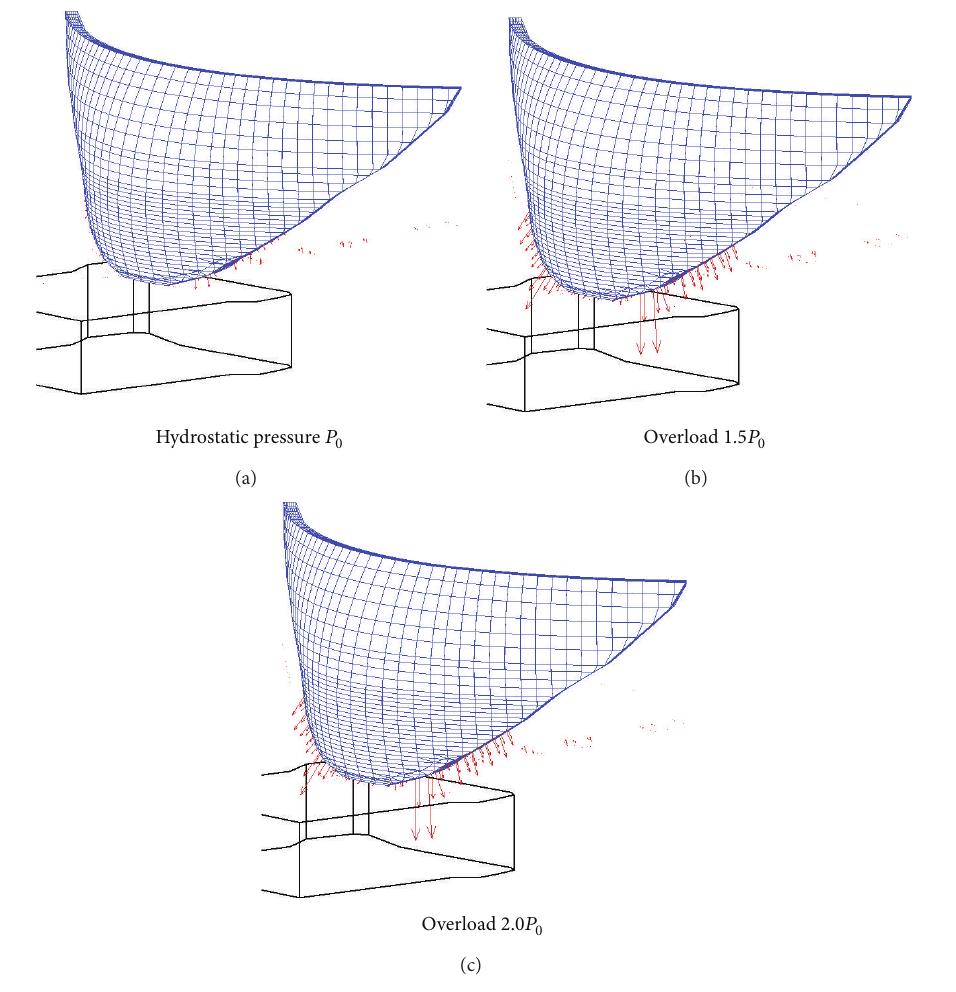
Figure 12: Distribution of dam heel unbalanced force of scheme 1.